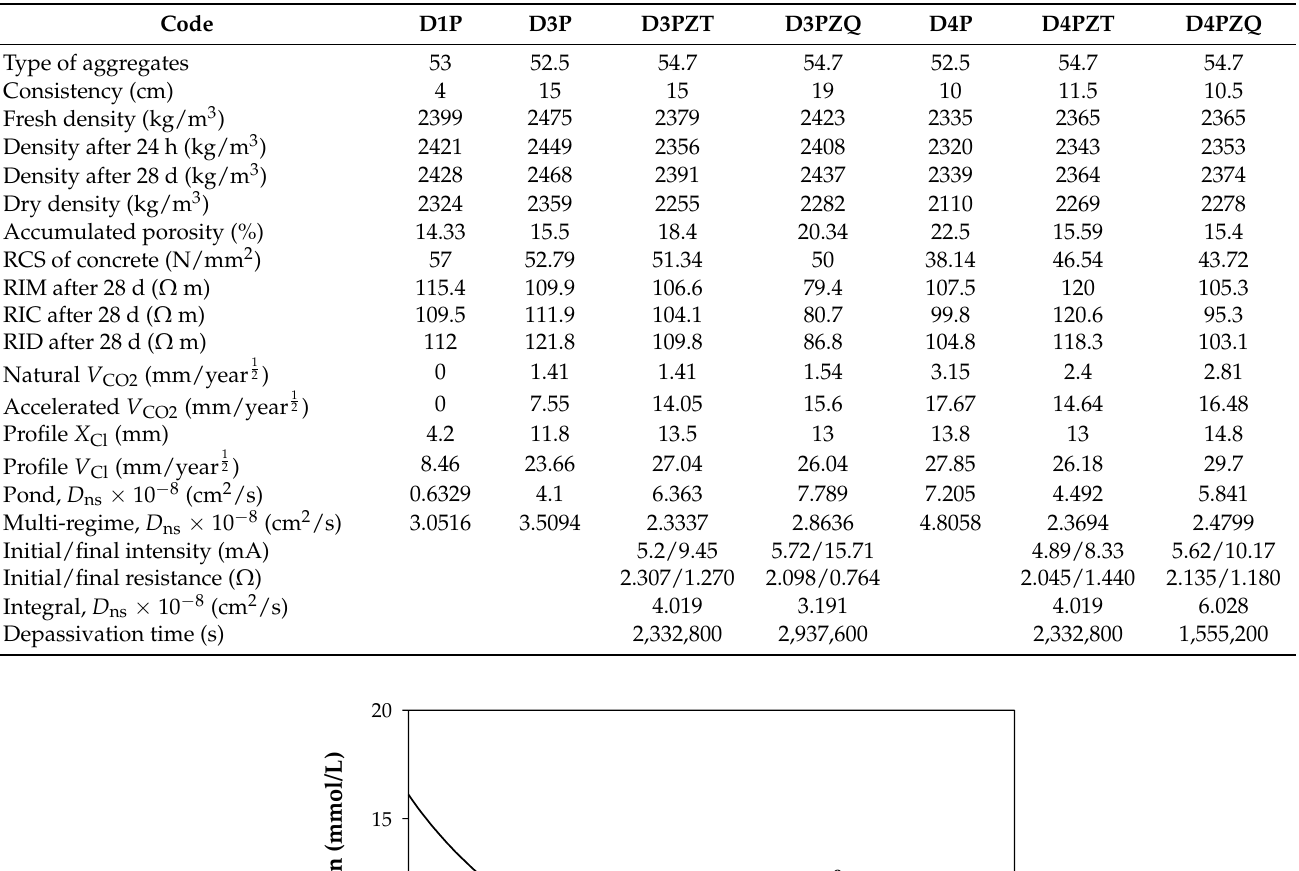
Table 7. Experimental results of the tests made on the concrete mixtures.